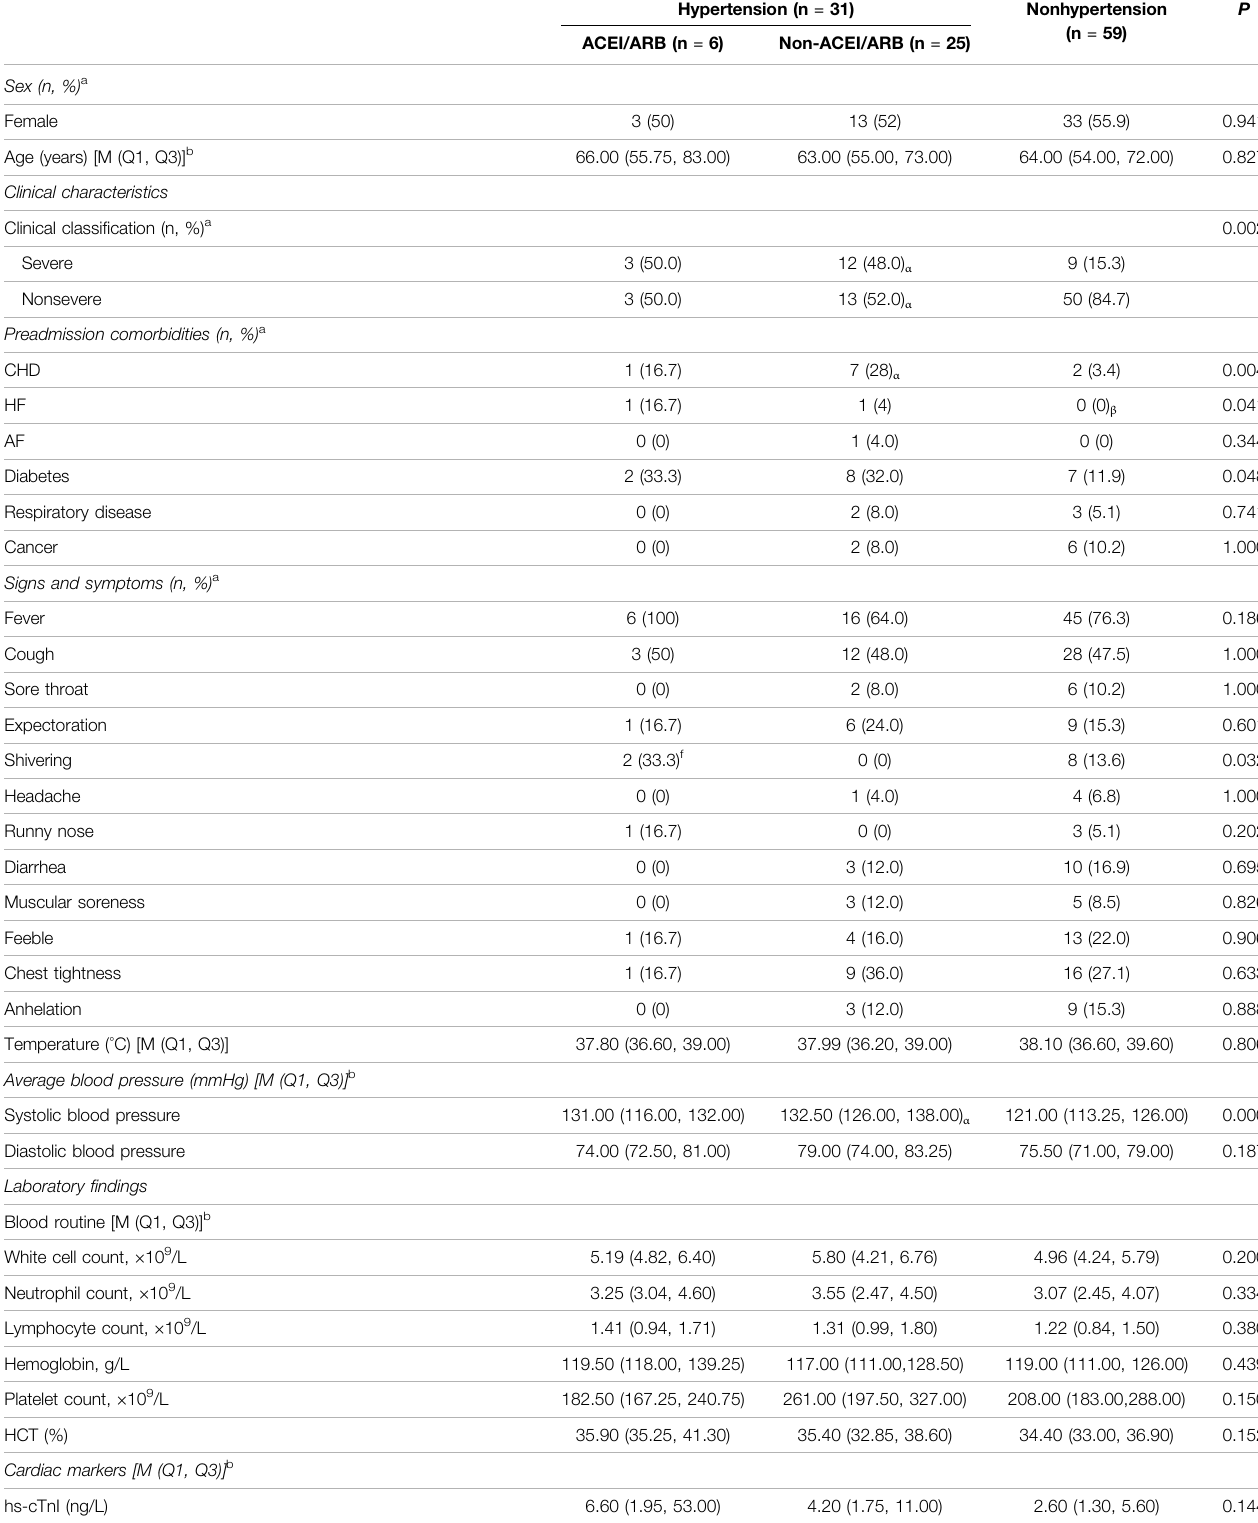
TABLE 2 | The comparison of demographic and clinical characteristics, laboratory and radiology fi ndings, clinical measures, clinical outcomes, and severity of COVID-19 among ACEI/ARB, non-ACEI/ARB, and nonhypertension